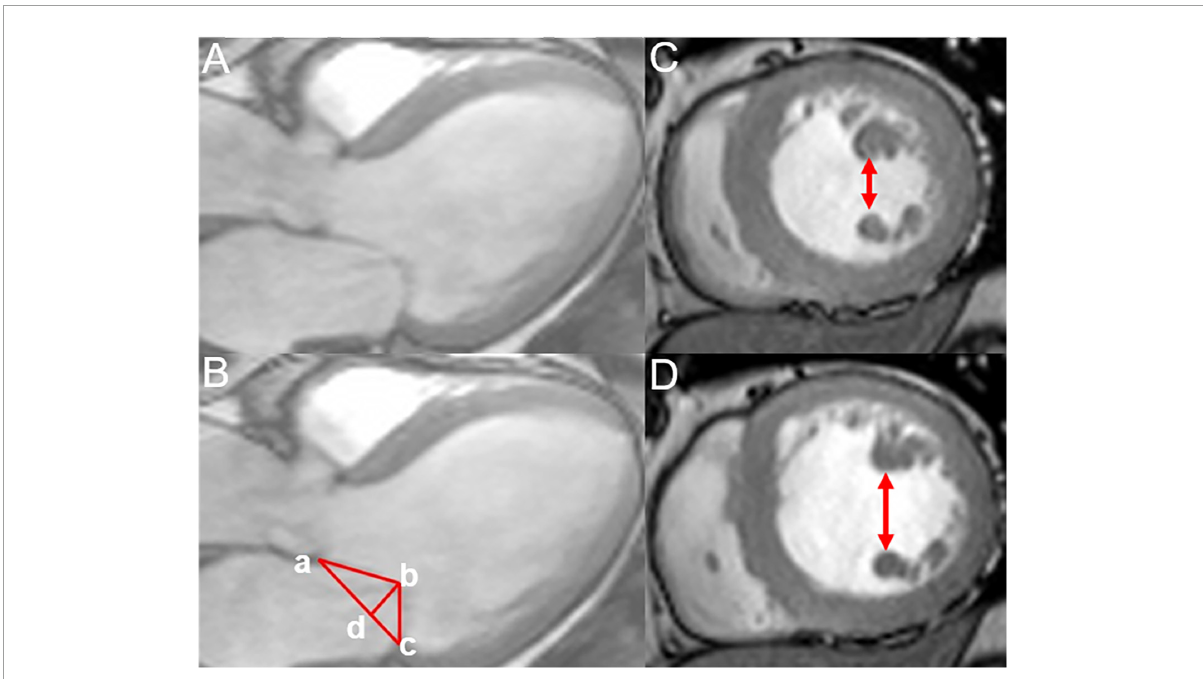
FIGURE2 Measurement of the mitral annular geometric parameters and interpapillary muscle distance. (A,B) Measurement of the annular geometric parameters using cardiac magnetic resonance under a three-chamber view (mid-systolic); tethering height (b–d),mitral annular diameter (a–c), tethering area (enclosed by a–b–c), posterior tethering angle = bca, and anterior tethering angle = bac. (C,D) Measurement of the interpapillary muscle distance during end-systolic and end-diastolic periods under the short axis.